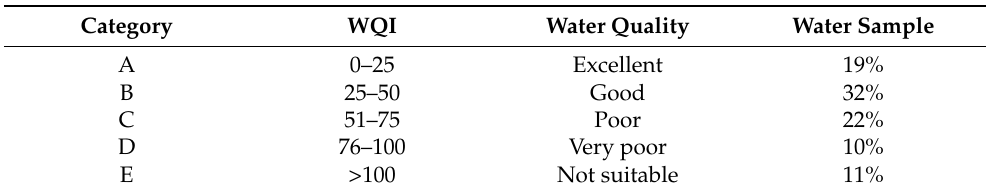
Table 5. Classification of water quality based on the WQI.